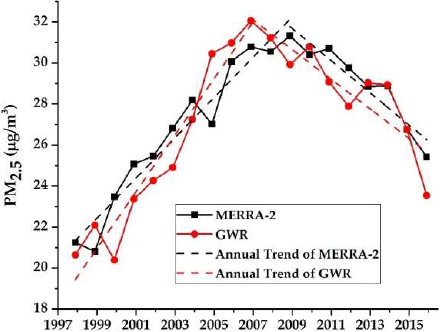
Figure A3. Temporal variations of annual mean PM 2.5 concentration derived from MERRA-2 (black) and GWR (red) over the YRB from 1998 to 2016.